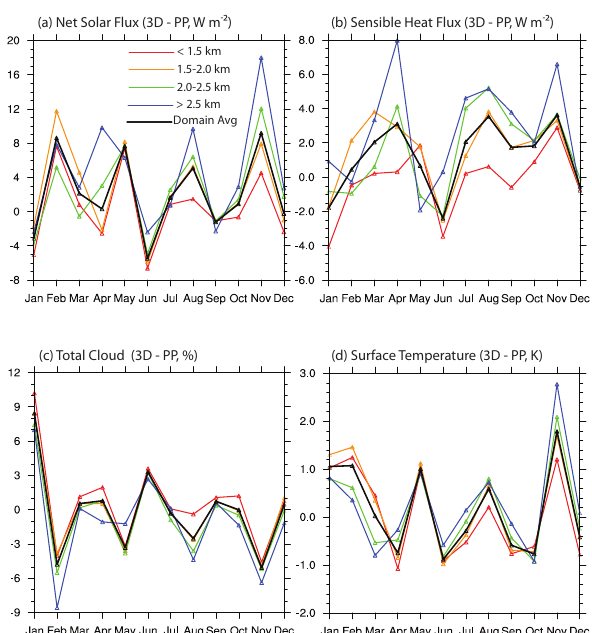
Figure 4. Deviations (3-D–PP) in the domain-averaged monthly Fig. 4 (a) net solar flux, (b) sensible heat flux, (c) total cloud fraction, and (d) surface temperature for a 12-month period as a function of elevation lower than 1.5km (red), 1.5–2km (orange), 2–2.5km (green), above 2.5km (blue), and for the whole domain (black). Figure 5. The monthly mean (a) snow water equivalent (SWE,